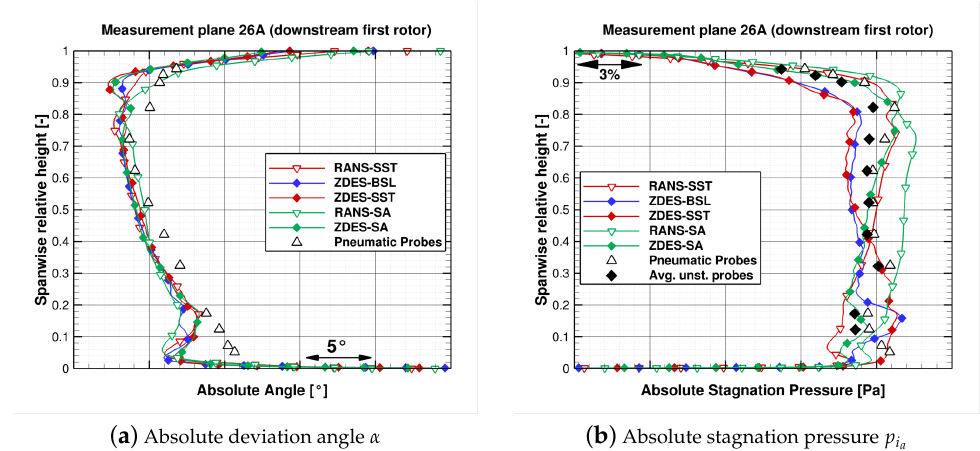
Figure 5. Radial profiles in plane